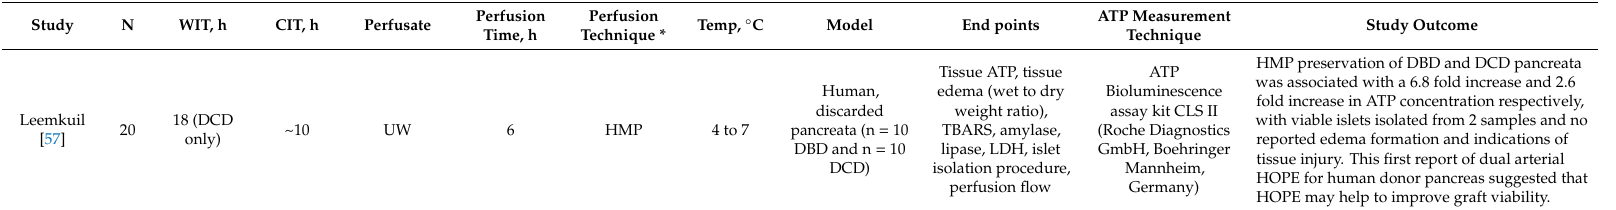
Table 8. Characteristics and outcomes of key pre-clinical study investigating HMP preservation of pancreas